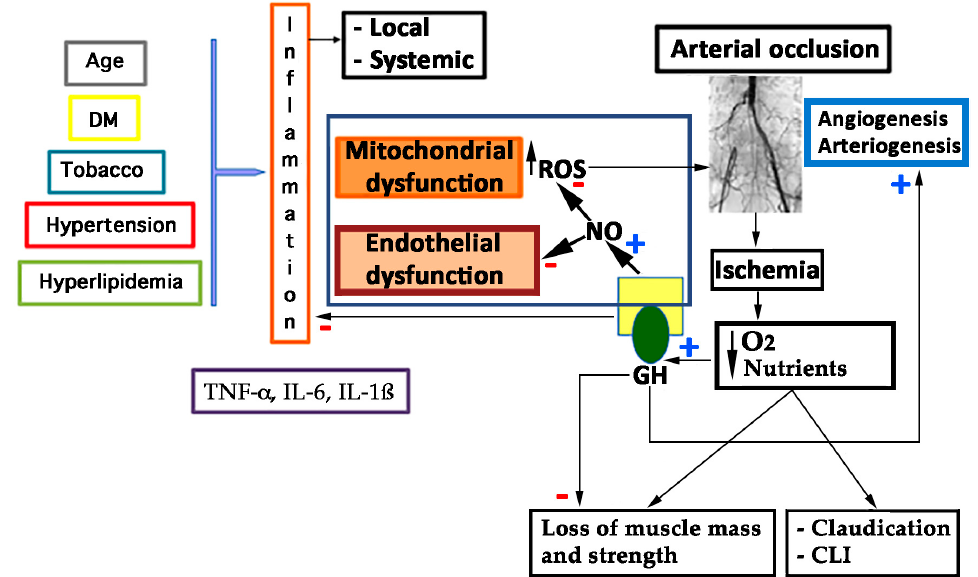
Figure 3. Cardiovascular risk factors converge to produce inflammation with increasing of TNF- α , IL-